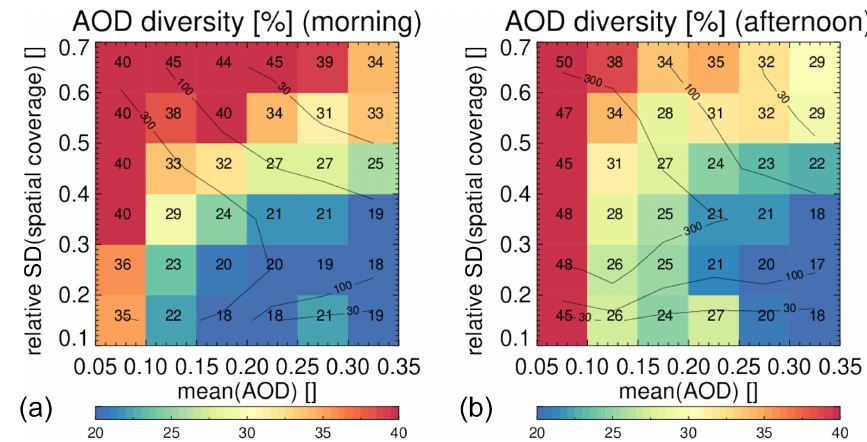
Figure 22. Diversity in AOD amongst morning and afternoon products as a function of mean AOD and the relative standard deviation in spatial coverage. The values in each bin show averaged diversity (similar to the colour). The contour lines show data density. Morning (a) and afternoon (b) products were collocated within 3h. The statistics are dominated by observations over land. Over ocean, similar patterns are found but the range in diversity is much